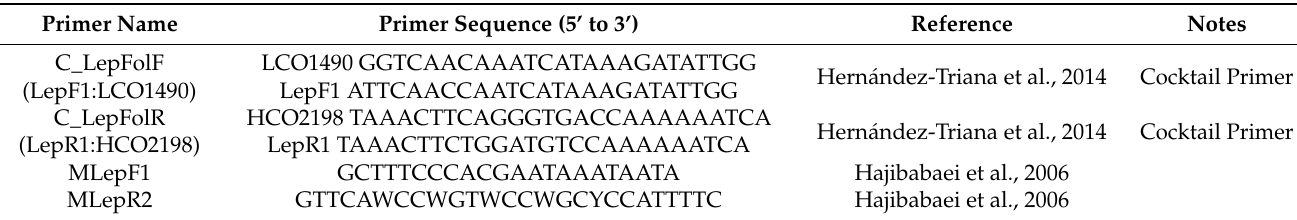
Table 1. Sequences of COI